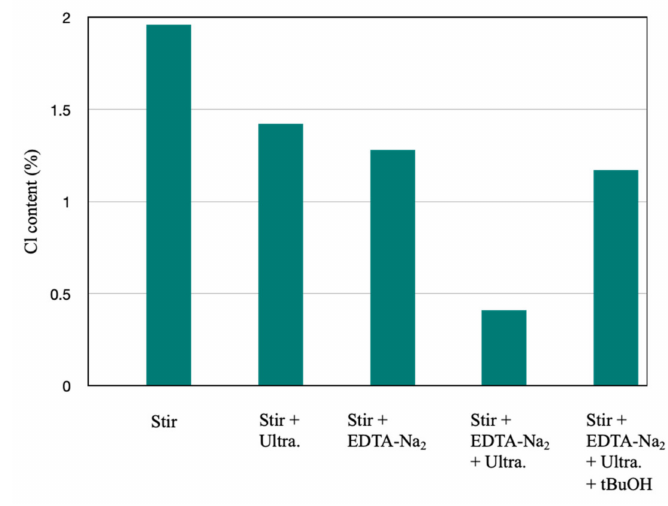
Figure 8. Cl contents after different treatment conditions.